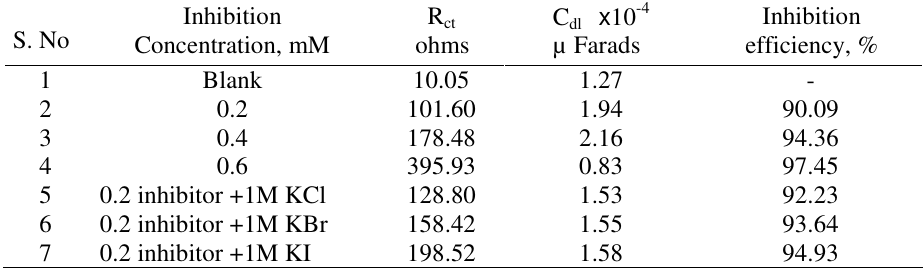
Table 9 . Impedance parameters for the corrosion of mild steel in 1 M H without